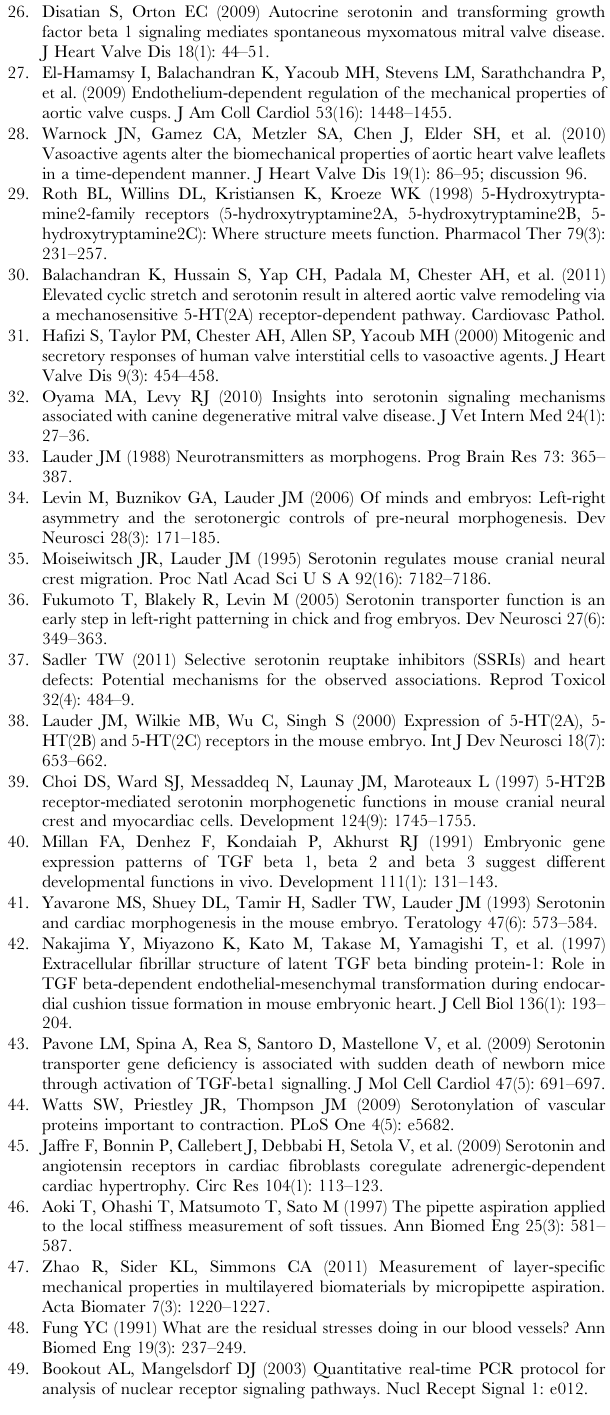
(arrow) and unclosed chest (dashed line) observed with both 5-HT treatment and thoracotomy sham controls.